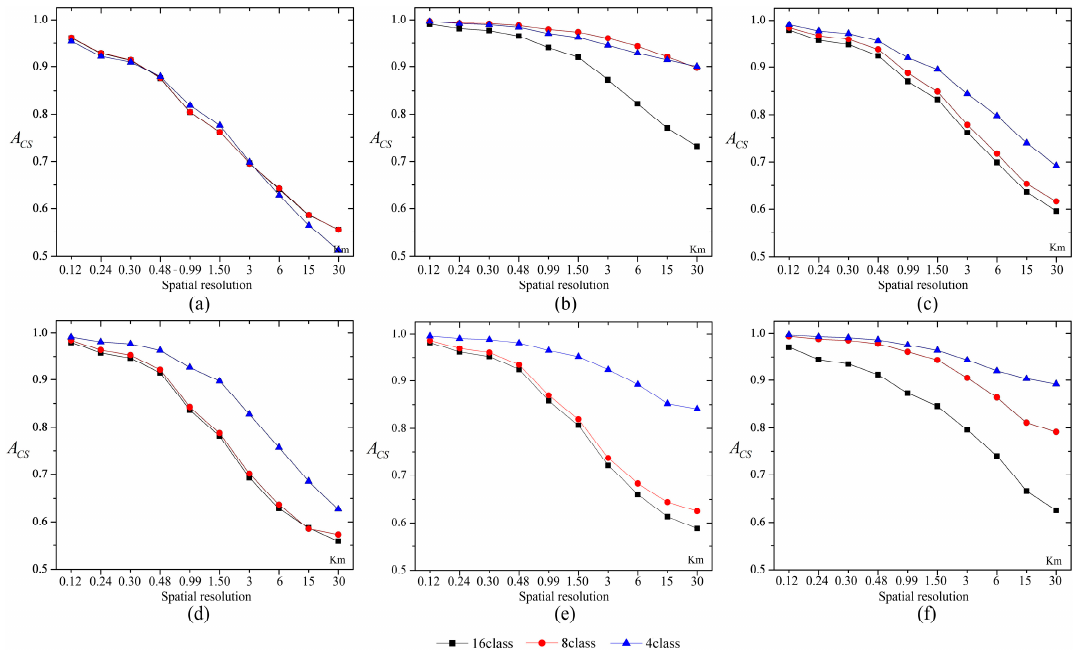
Figure 7. The A cs values during 2001–2011 with different land cover class schemes. ( a – f ) Represent the results of the study areas A to F, respectively.